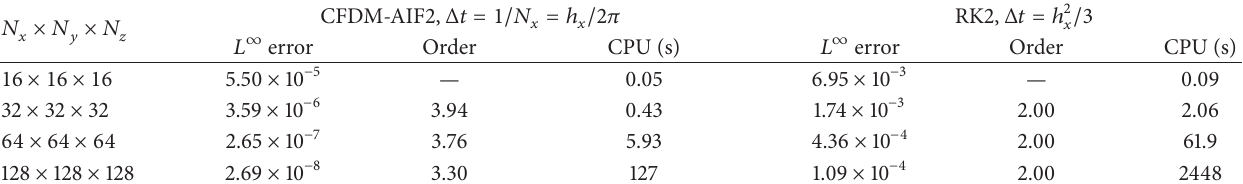
Table 1: Error, order of accuracy, and CPU time with CFDM-AIF2 and RK2 scheme for Example 1. CFDM-AIF2, Δ𝑡 = 1 /𝑁 𝑥 = ℎ 𝑥 / 2 𝑁 × 𝑁 × 𝑁 𝑥 𝑦 𝑧